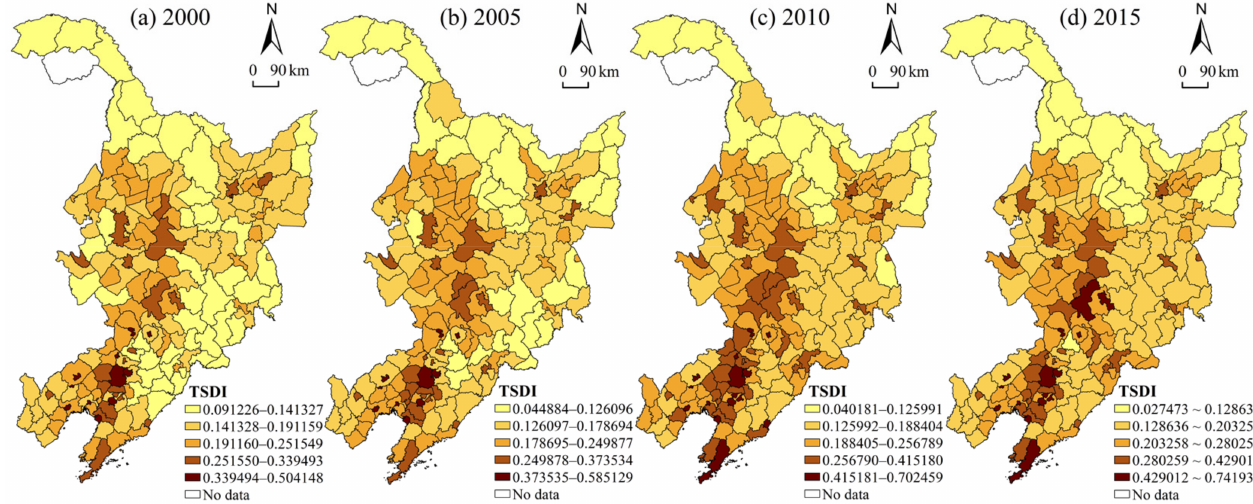
Figure 3. Spatial pattern of TSDI in Northeast China for the years ( a ) 2000; ( b ) 2005; ( c ) 2010; ( d ) 2015. On the time scale in Figure 4 (2000–2015), the TSDI in Northeast China indicates that the development intensity increases year by year, with the most significant increase from 2005 to 2010. The overall TSDI of the three provinces in Northeast China was significantly different from 2000 to 2015 ( p < 0.05); while the difference between